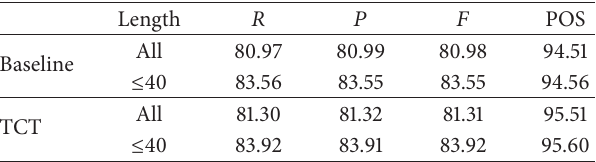
Table 7: POS and parsing accuracy on TCT in graph-based OOV